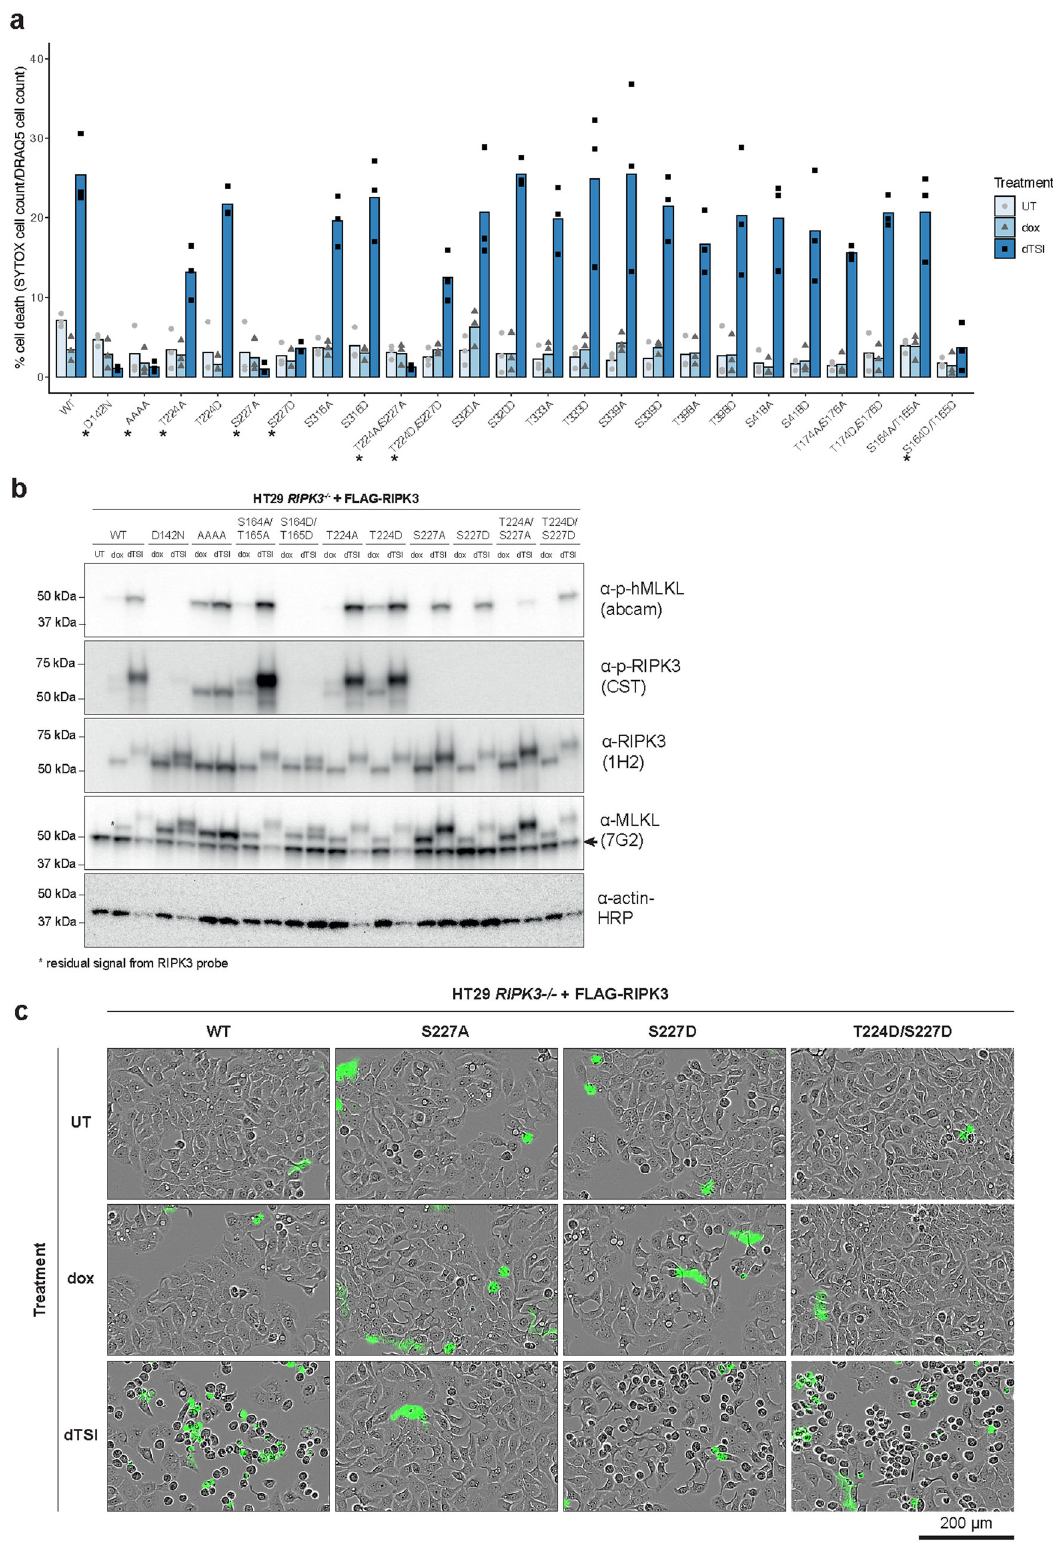
(Fig. 2b). Similarly, phosphorylation of S320, T333, and S339 was detected predominantly in wild-type, but not D142N, RIPK3, implicating them as autophosphorylation sites. Phosphorylation of RIPK3 S176, S320, and T333 were only detected following TSI